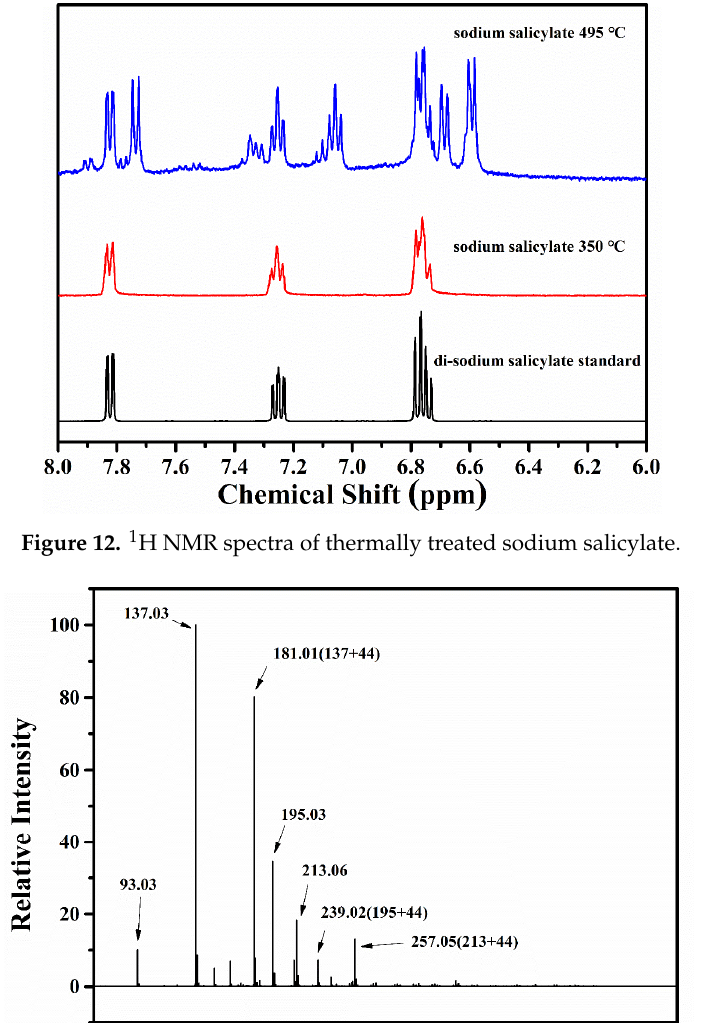
Figure 13. Q-TOF spectrum of sodium salicylate collected at 495 °C.